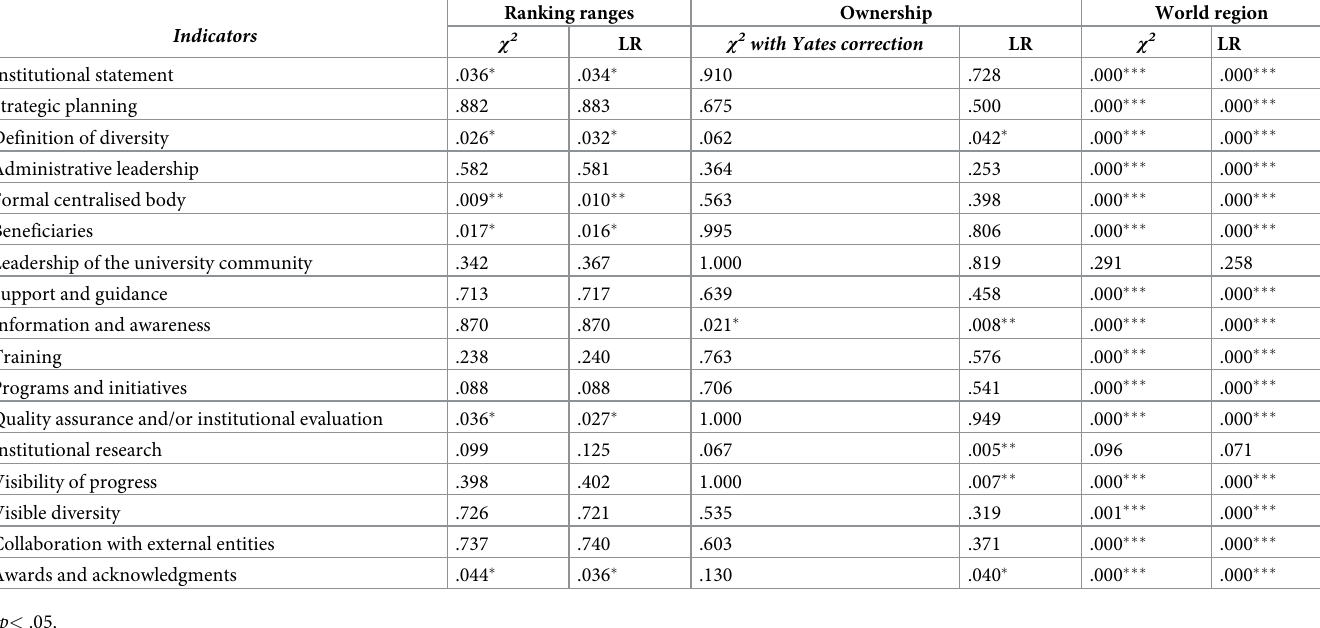
Table 2. Error associated ( p ) with the values reported by the Chi-Squared and Likelihood Ratio tests in determining the statistical differences in fulfilment of insti- tutionalisation indicators according to the ranking ranges, type of ownership and world region.